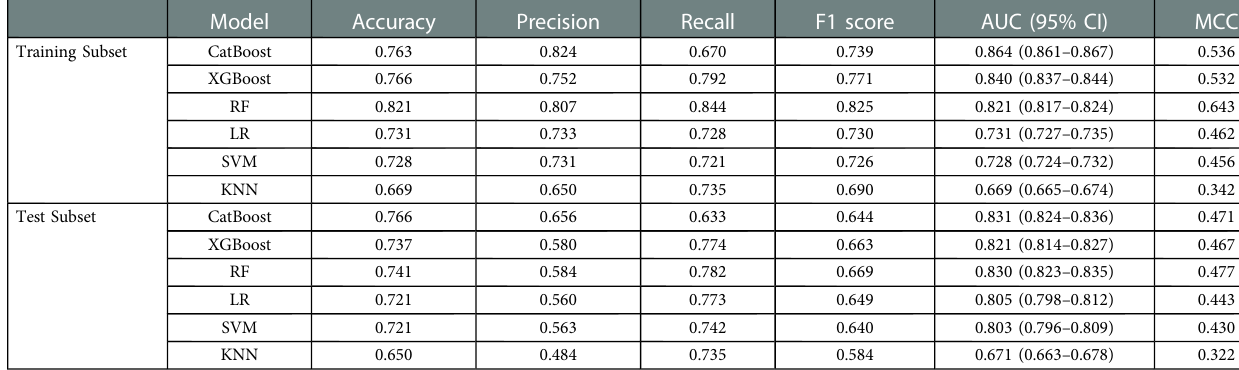
TABLE 2 The prediction performance of different machine learning models in the training subset and test